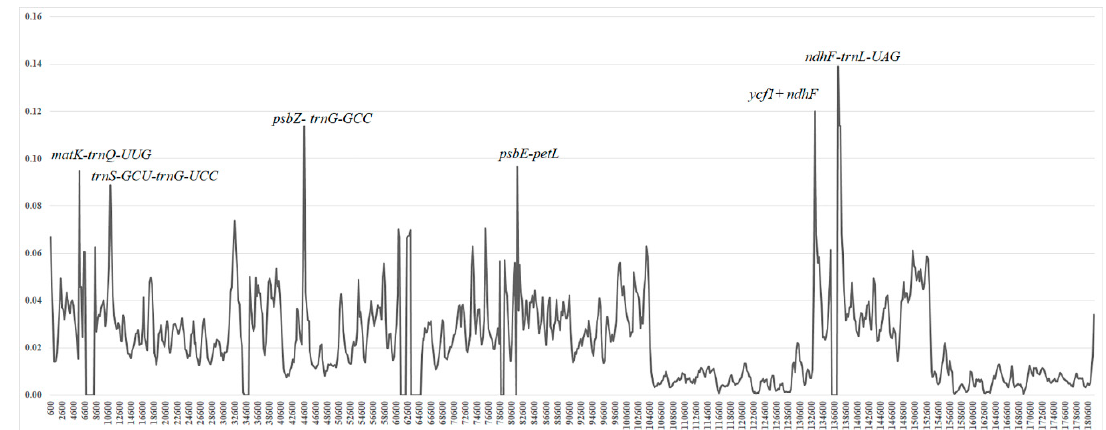
Figure 4 . Comparison of the nucleotide variability (Pi) values of the plastomes. X -axis: position of the midpoint of a window, Y -axis: nucleotide diversity of each window (window length: 600 bp and step size: 200 bp).